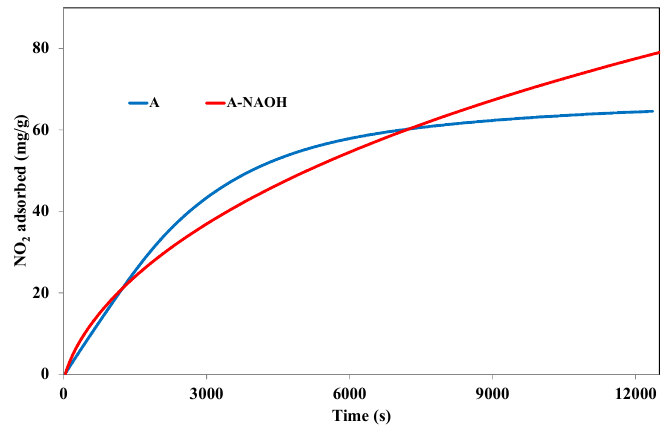
Figure 12. NO 2 adsorption capacities at 25 °C for the activated carbons A and A-NAOH.